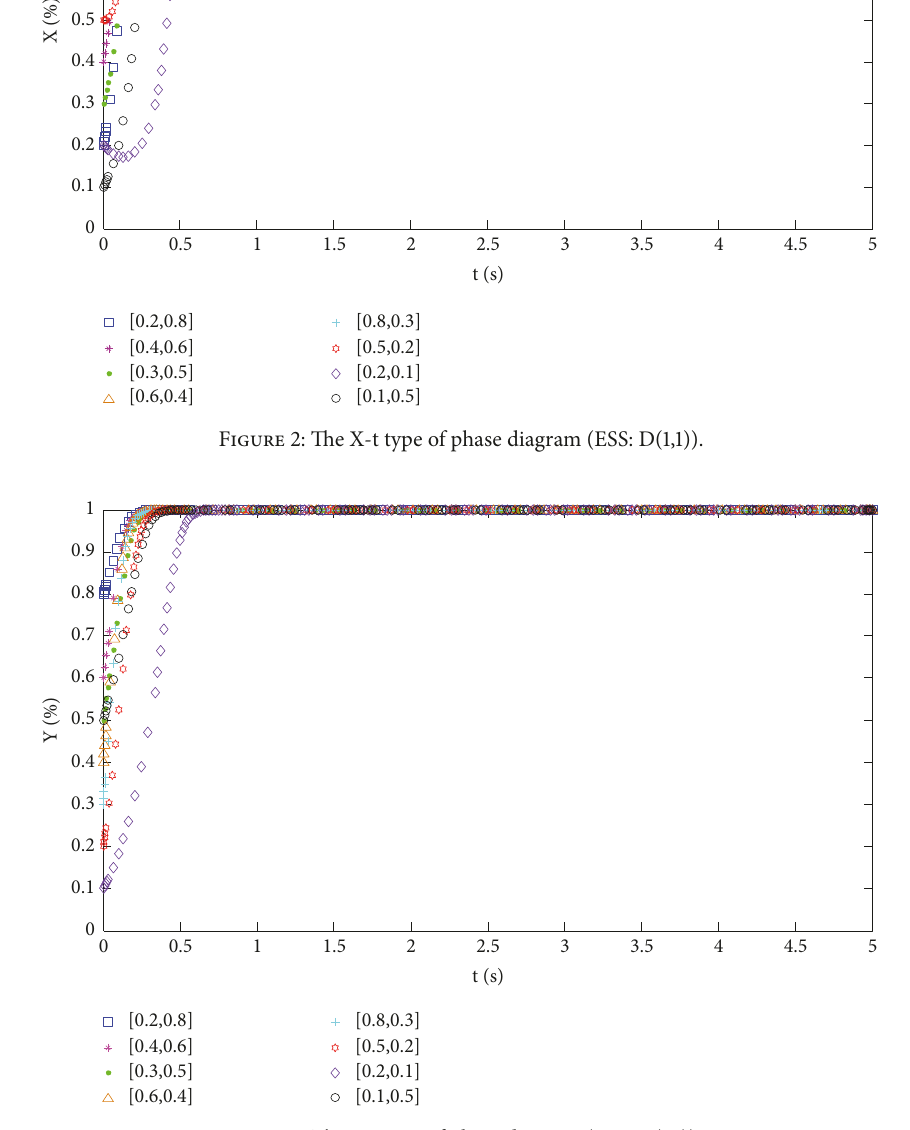
Figure 3: The Y-t type of phase diagram (ESS: D(1,1)).